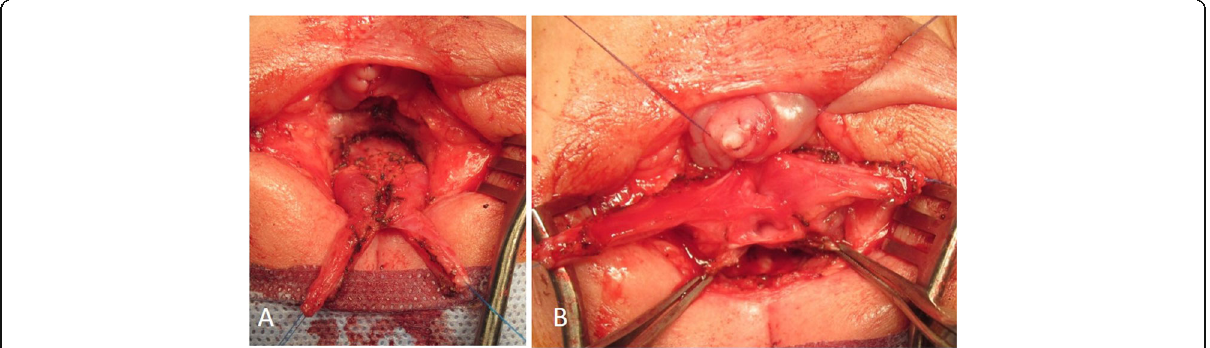
Fig. 7 Feminizing genitoplasty (cont.). A 10-month-old girl with CAH (same case in Fig. 5). The dissected urogenital sinus is split into two